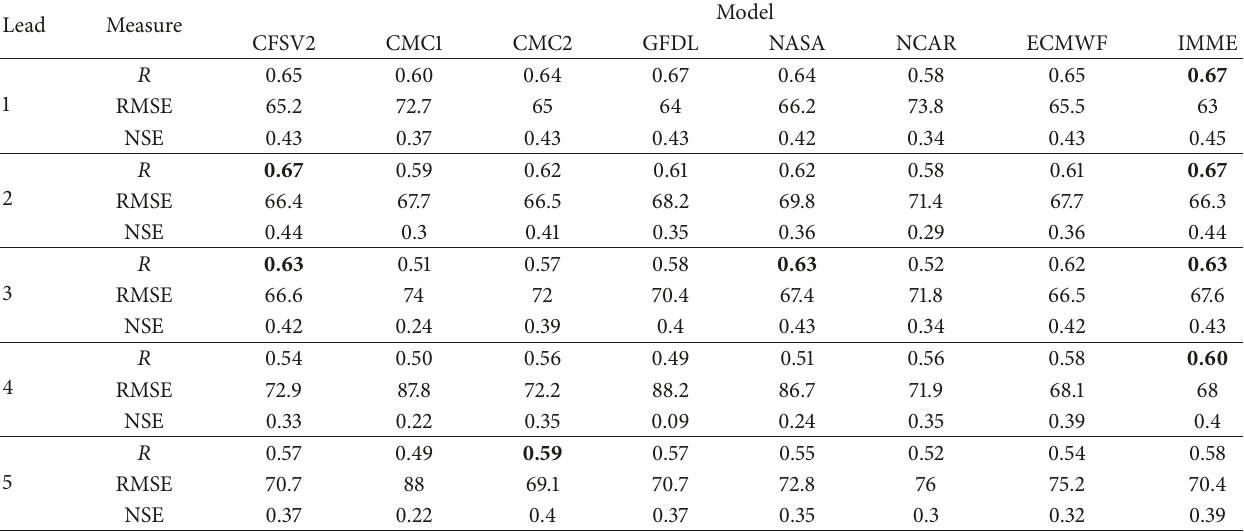
Table 2: Correlation, RMSE, and NSE for observed monthly precipitation versus the models predictions: one to five months’ lead times, Northern Israel, Latitude: 33.0, Longitude: 35.0.